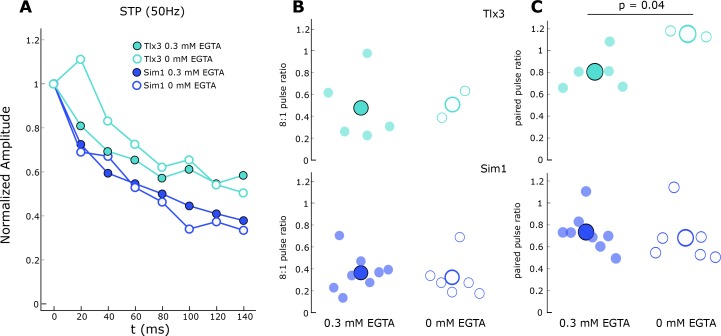
Influence of internal EGTA on short-term dynamics.(A) Normalized response amplitude during a 50 Hz train in Tlx3 (cyan) and Sim1 (blue) connections with 0.3 mM EGTA present in the internal solution (filled) and in the absence of EGTA (open). Data are grand average of all connections within each type. (B) Ratio of the last (8th) pulse in the train to the first for each connection within each type (small circles) and the grand mean (large circle); colors and fill follow as in A. (C) Paired-pulse ratio for each connection within each type (small circles) and the grand mean (large circles); colors and fill follow as in A.10.7554/eLife.37349.024Figure 5—figure supplement 1—source data 1.Influence of internal EGTA on short-term dynamics.